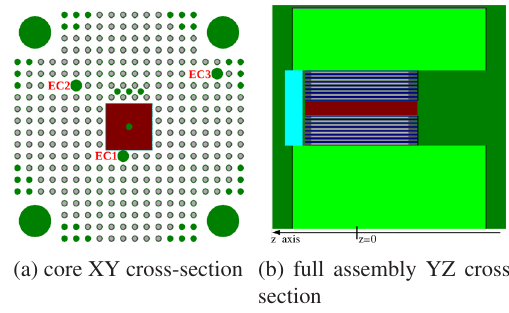
Figure 2: Yalina-Thermal computer model visualization